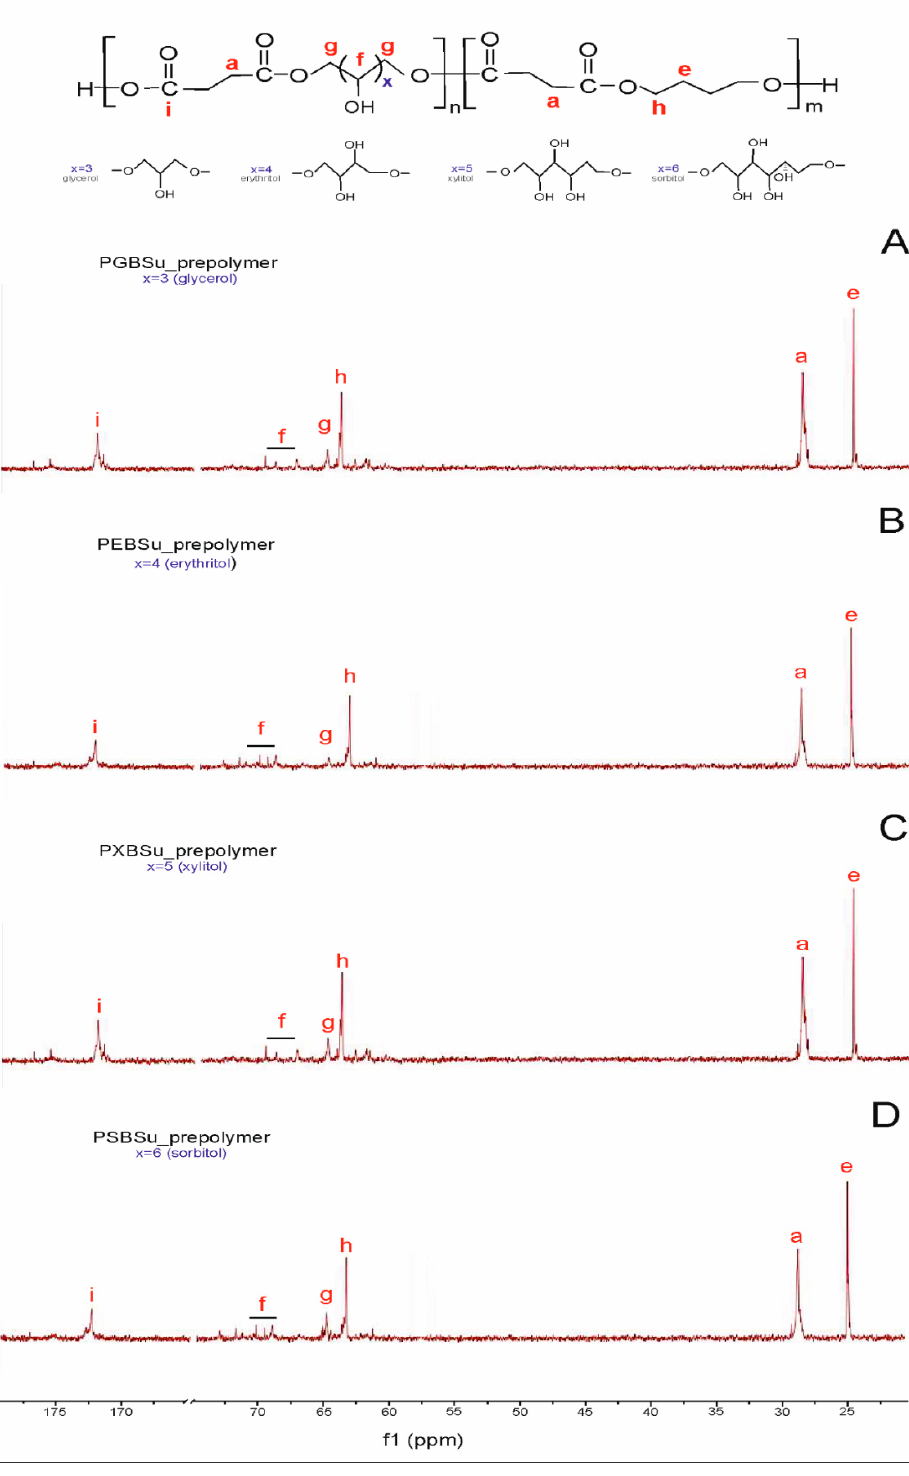
Figure 2. 13 C NMR of PGBSu ( A ), PEBSu ( B ), PXBSu ( C ), and PSBSu ( D ) prepolymers.